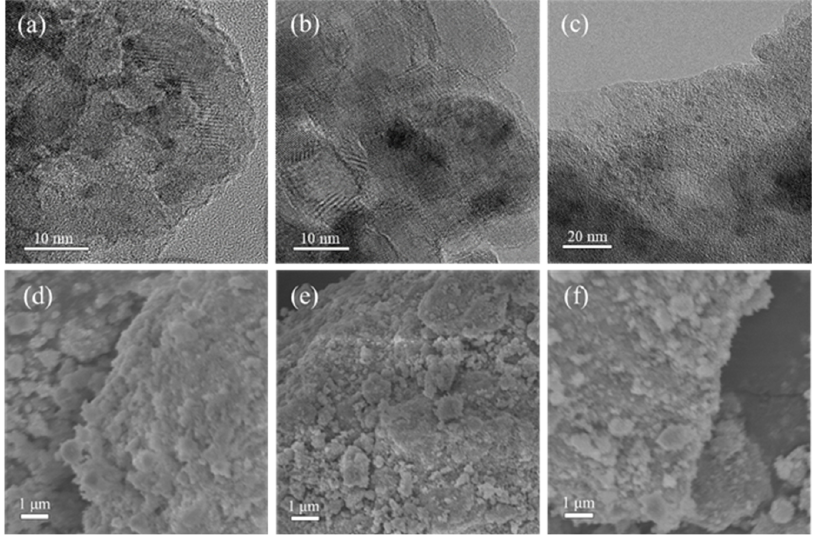
Figure 4. TEM and SEM images of the Pt/CeTi ( a , d ), Pt/Keg-CeTi ( b , e ), and Pt/MoP-CeTi ( c , f ) cata- lysts. ( c , f )